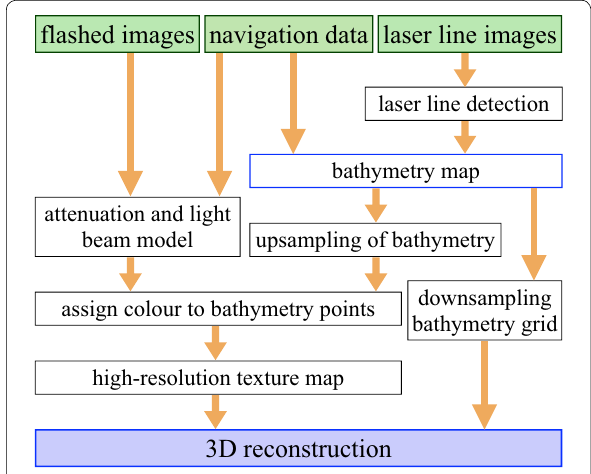
Fig. 3 Flowchart showing the basic steps of the data processing